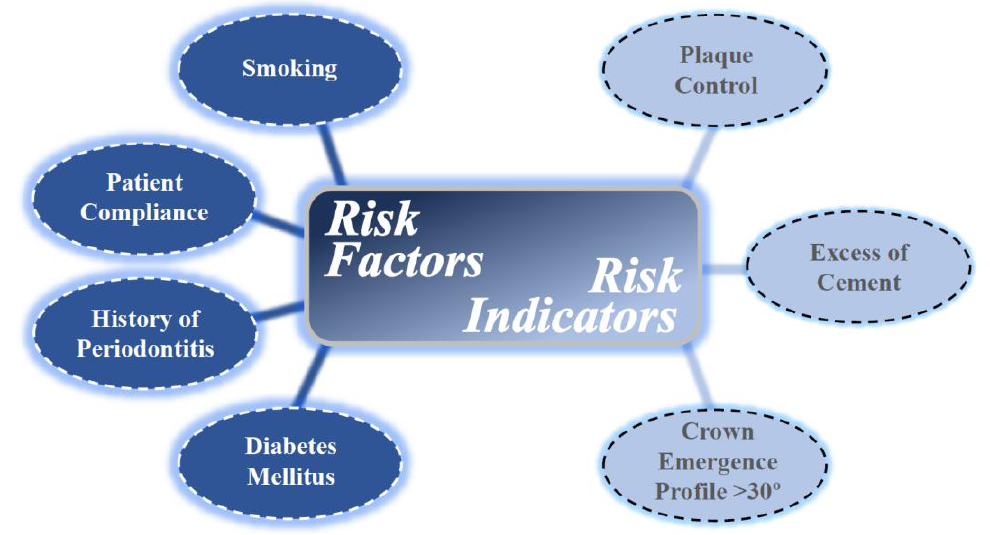
Figure 2. Risk factors and indicators of peri-implant diseases.